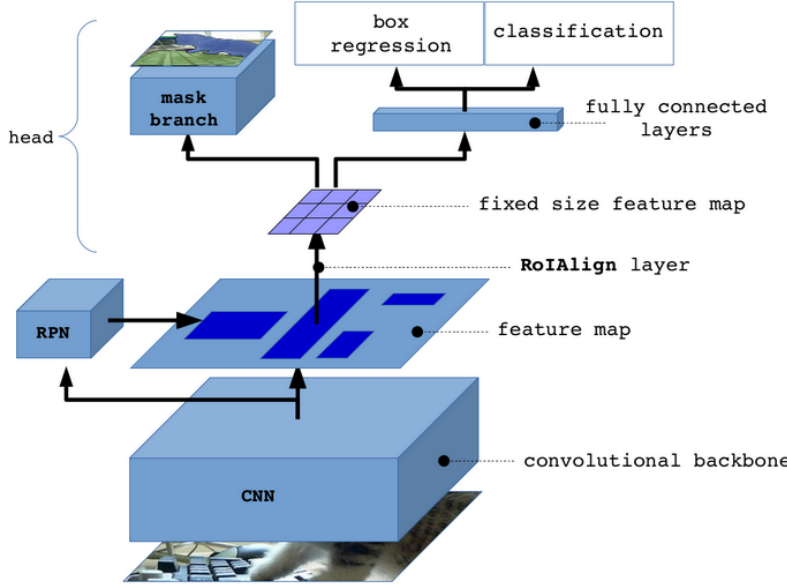
Figure 11. Mask R-CNN architecture